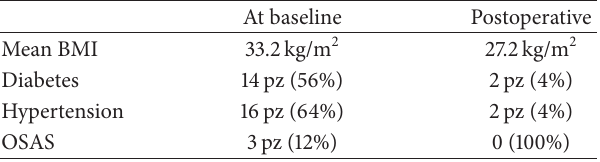
Table 1: BMI and comorbidities after bariatric surgery. At